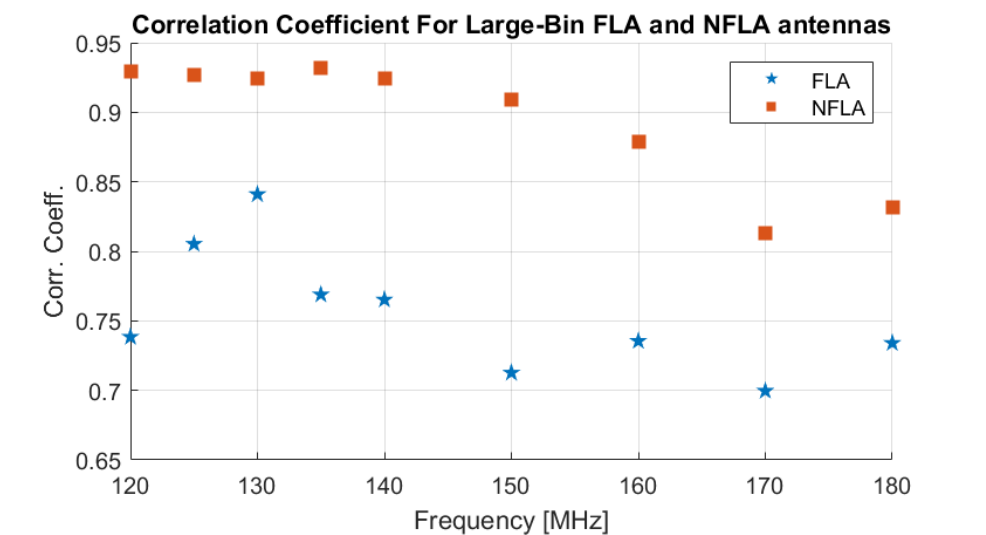
Figure 16. Comparison of FLA and NFLA correlation coefficients in the two 800 bu